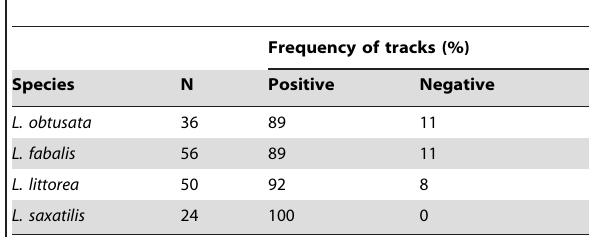
Table 2. Polarity of trail-following in male Littorina